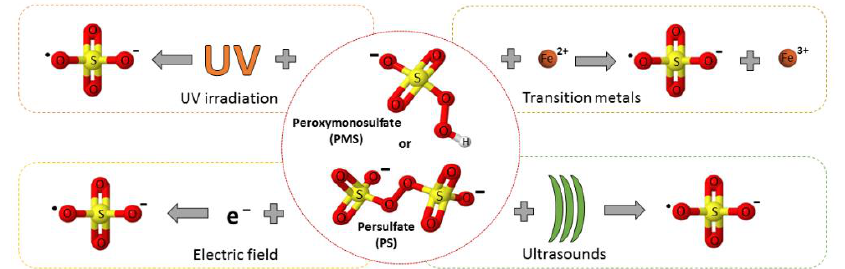
Figure 1. Different activation methods of persulfate and peroxymonosulfate in order to generate sulfate radicals.